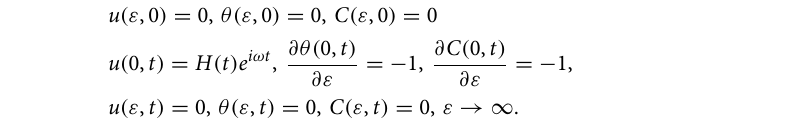
The thermo-physical property of graphene (nanoparticles) and engine oil (base fluid) are tabulated in table.